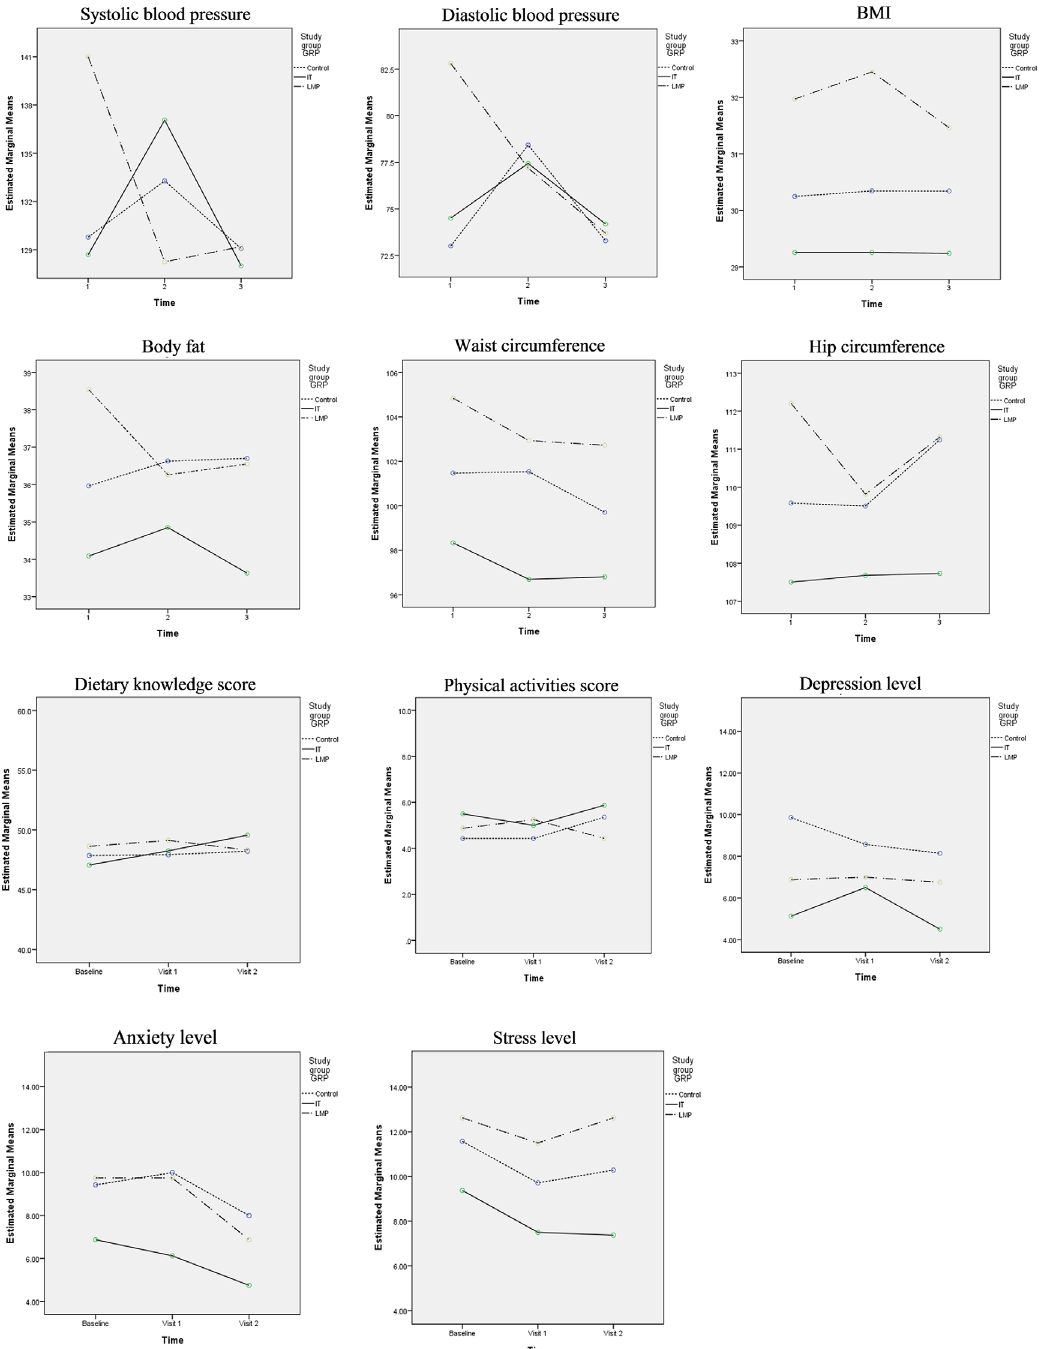
Fig 4. Comparison of secondary outcomes between subject groups at each visit. Comparison (repeated measures) between control (usual-care) group, internet (IT) intervention group and simplified lifestyle modification programme (sLMP) group for blood pressure, anthropometric measures, and scores for dietary knowledge, physical activity, depression, stress and anxiety over three time periods: baseline, 1 st visit (week 12) and final visit (week 24).